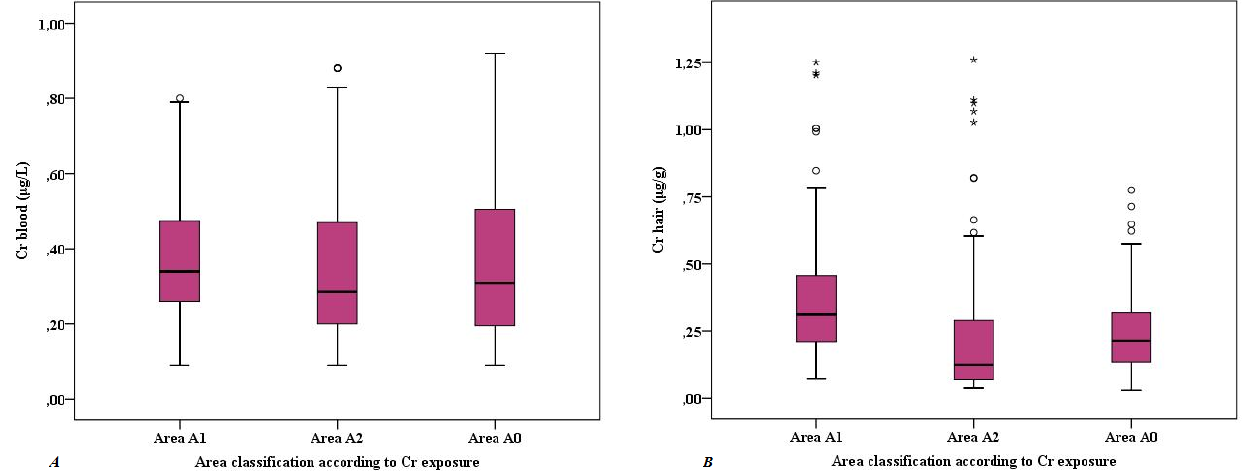
Figure 2. Chromium concentrations in blood (A) and hair (B) samples of the subjects in the three areas.